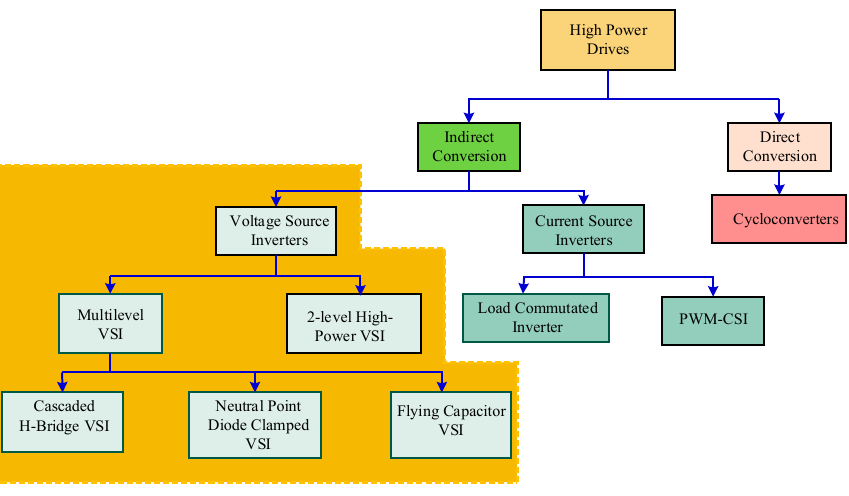
Figure 1. Classification of voltage source inverters (VSIs) in high power drives.